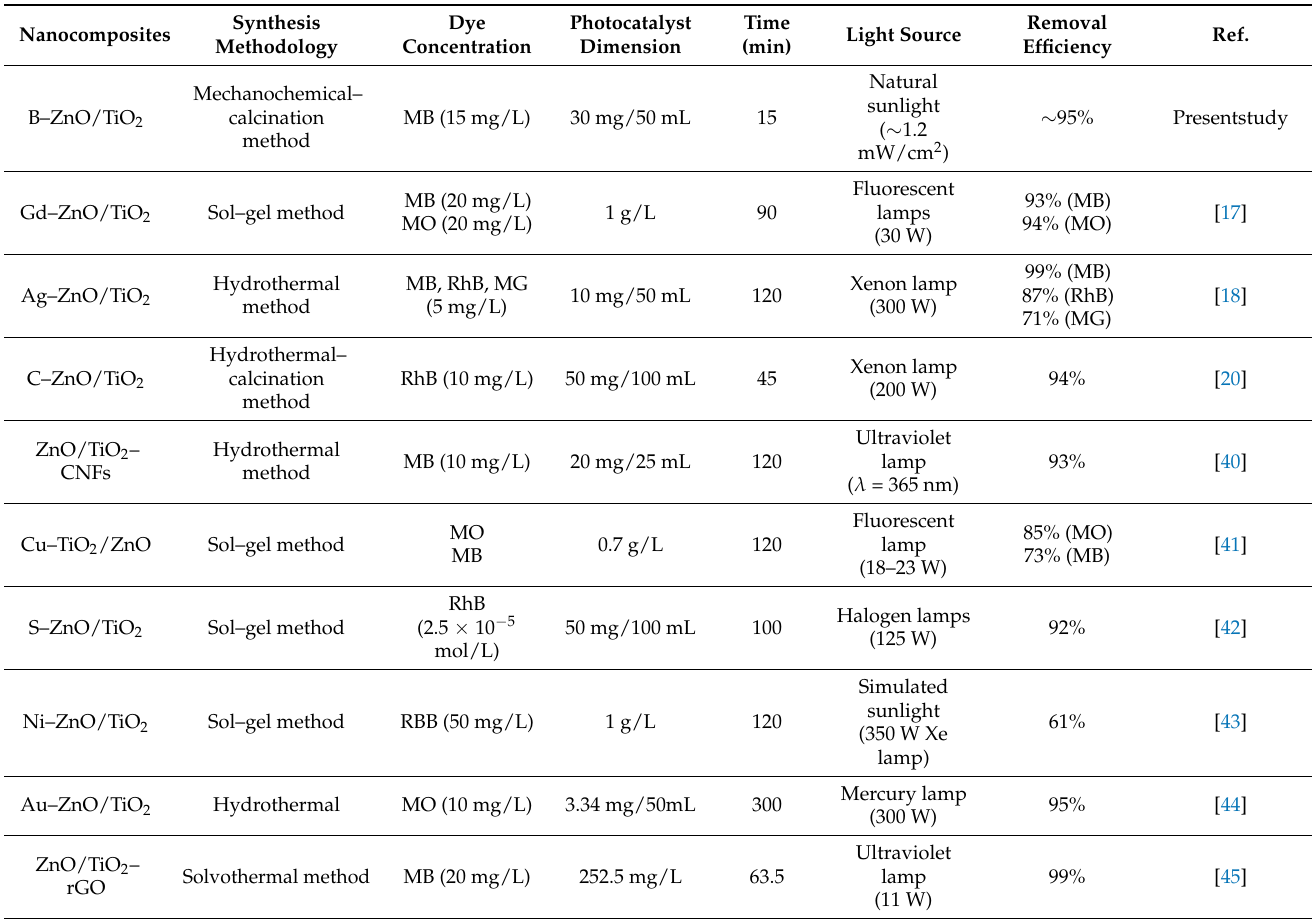
Table 2. Comparison of the photocatalytic activity of B–ZnO/TiO 2 nanocomposites with recently reported doped ZnO/TiO 2 nanocomposites for organic dye